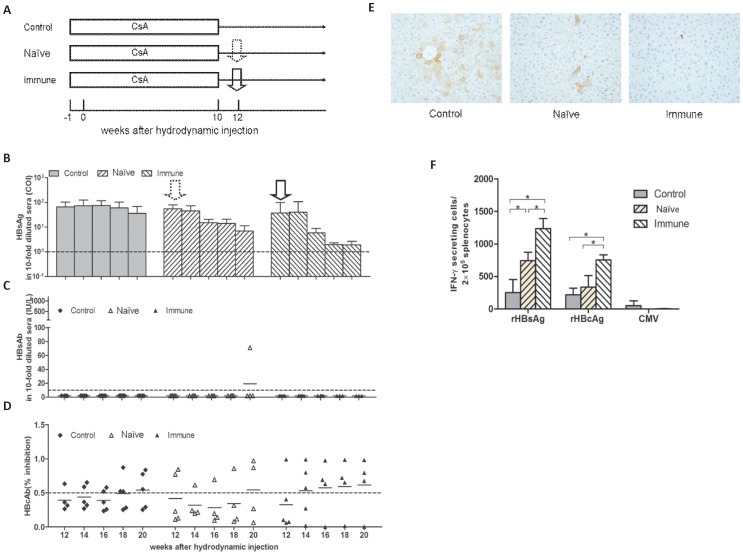
Adoptive immune transfer in mice with HBV persistence induced by CsA treatment.(A) Schema of the treatment. The mice were treated with CsA from 1 week before the HI to 10 weeks after the HI. Two weeks later, the mice were adoptive transferred with the splenocytes from naïve or pHBc-immunized mice. The levels of serum HBsAg (B), HBsAb (C), and HBcAb (D) in the mice were detected at the indicated time points. The cut off values of the HBsAg, HBsAb, and HBcAb are shown as dashed lines. (E) Liver samples were collected from the mice (n≥3) at week 24 post HI (12 weeks after the adoptive transfer), and intrahepatic HBcAg was detected by IHC (magnification 200×). (F) Splenocytes were prepared from the mice (n≥3) at week 24 post HI (12 weeks after the adoptive transfer), and pulsed with rHBsAg and rHBcAg, IFN-γ-producing cells were analyzed by ELISPOT, as described above. * P<0.05.